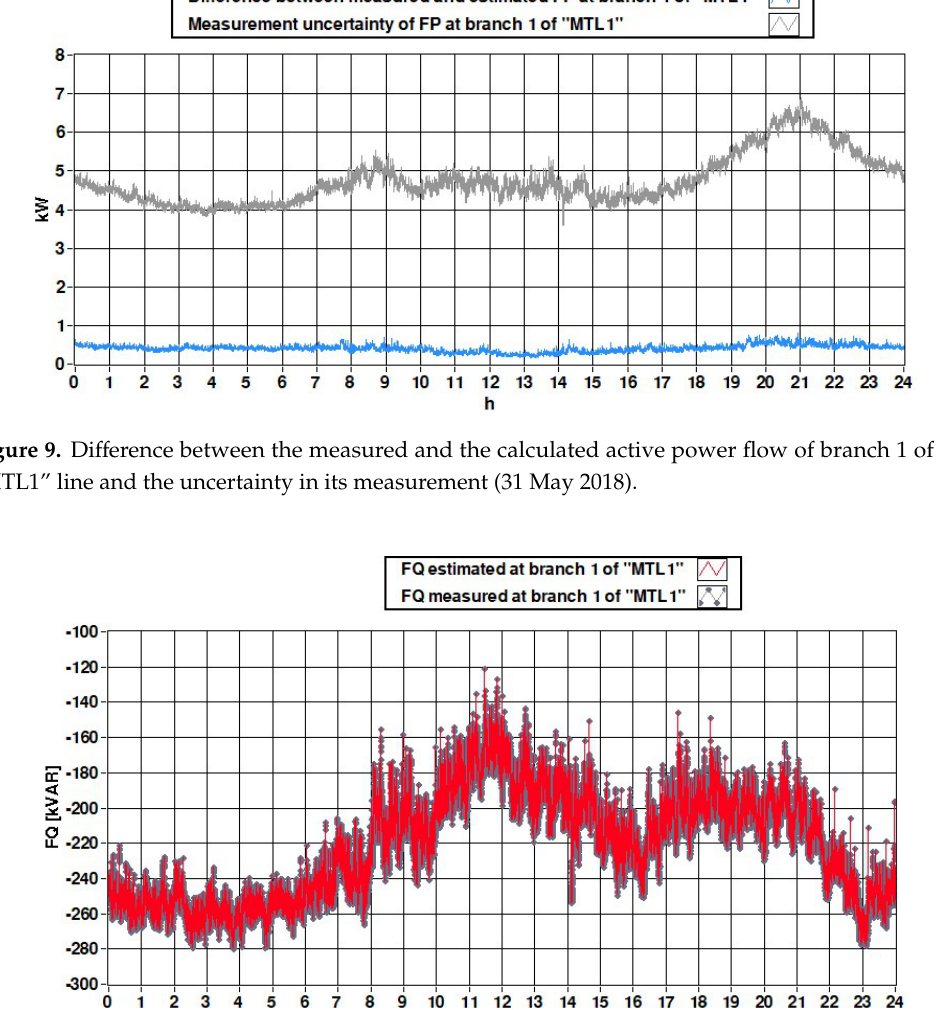
Figure 8. Comparison between the measured and the calculated values of the active power flow of first branch 1 of the “MTL1” line during the day 31 May 2018.